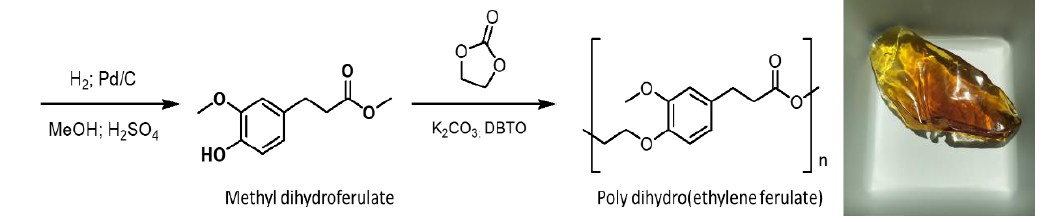
Figure 1. Synthesis of Poly-dihydro (ethylene ferulate) (PHEF).